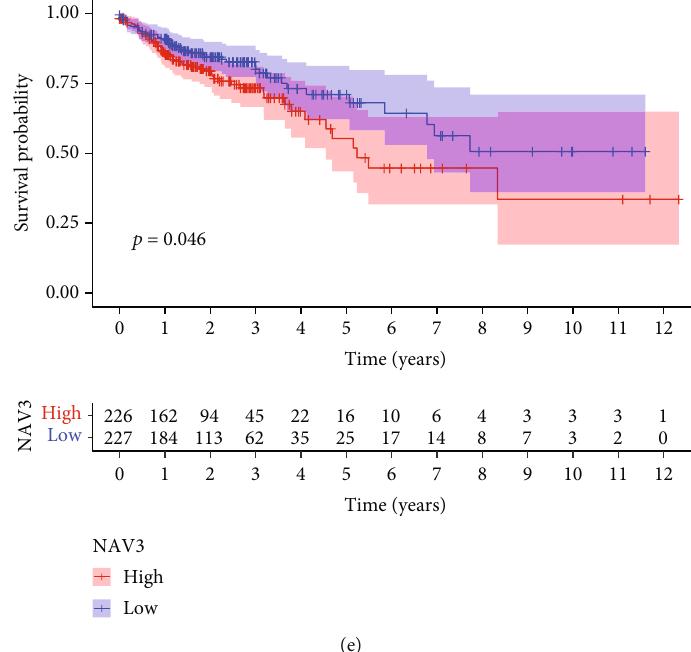
Figure 5: The expression of NAV3 and its clinical signi fi cance in CRC. (a) The expression of NAV3 was distinctly downregulated in CRC specimens. (b, c) The expressions of NAV3 in groups which were divided by age and gender. (d) Higher levels of NAV3 were observed in CRC specimens at di ff erent stages. (e) Kaplan-Meier curves estimating the overall survival according to the expression of NAV3 in patients with